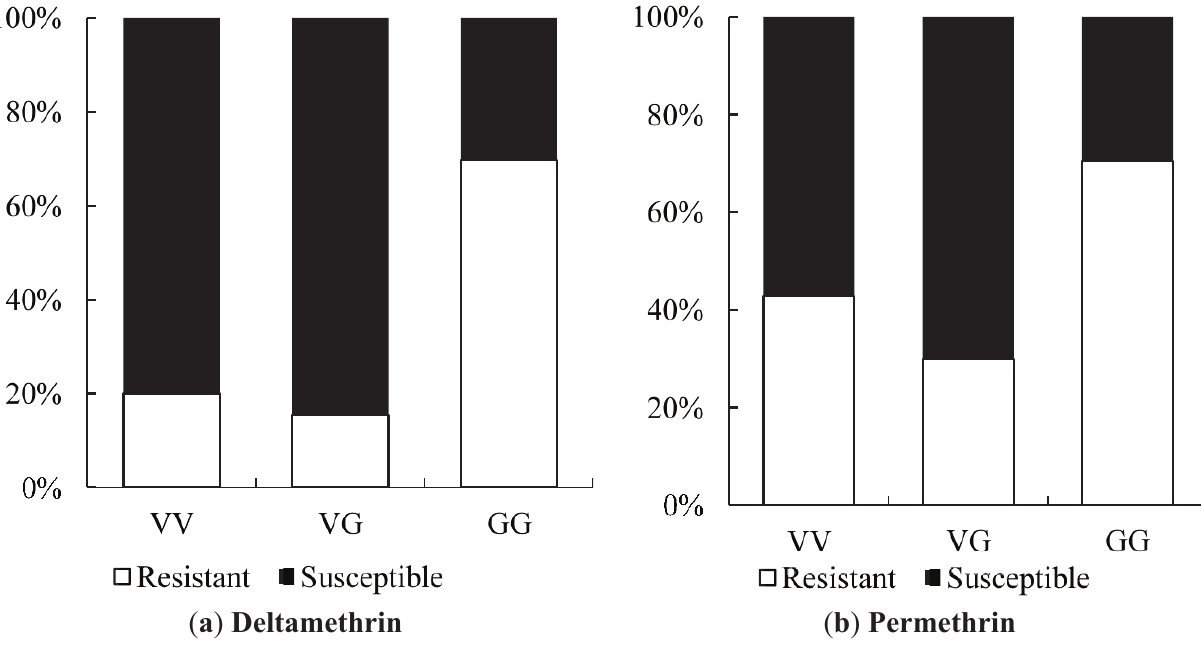
Figure 4. Association between Vssc V1023G mutation and pyrethroid resistance in Aedes aegypti from Yogyakarta (Site 6, Site 8 and w MelYog line). ( a ) Distribution of V1023G genotypes between deltamethrin-resistant and deltamethrin-susceptible mosquitoes. ( b ) Distribution of